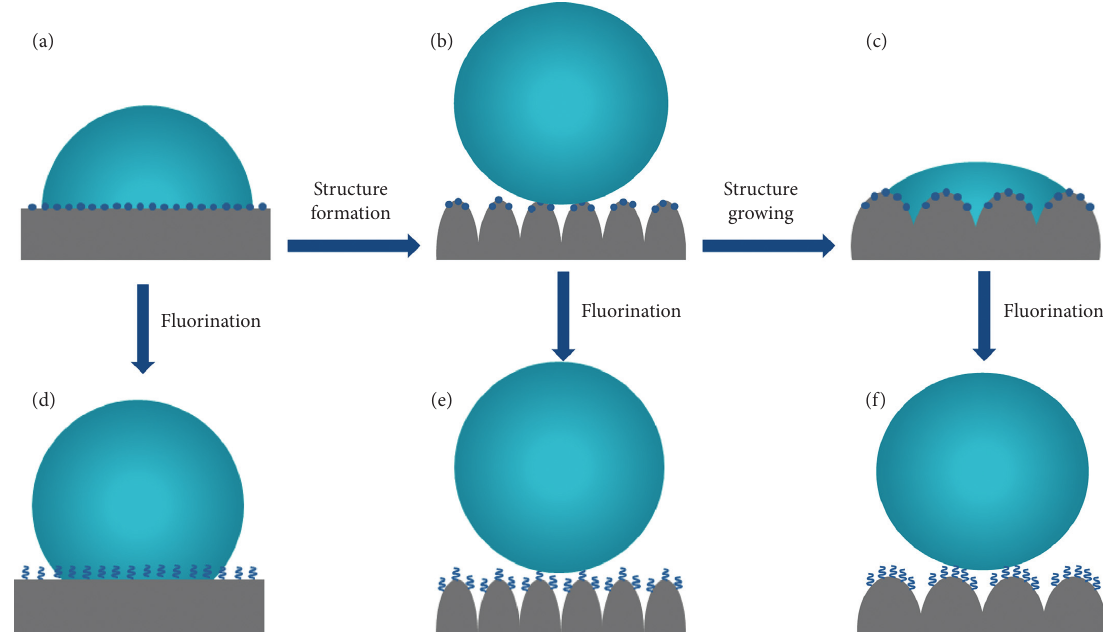
Figure 8: Wettability model of different specimens before and after fluorination. (a, d) SS, (b, e) S 1, and (c, f) S 6; : metallic bonds or hydroxyl groups and : hydrophobic functional groups.